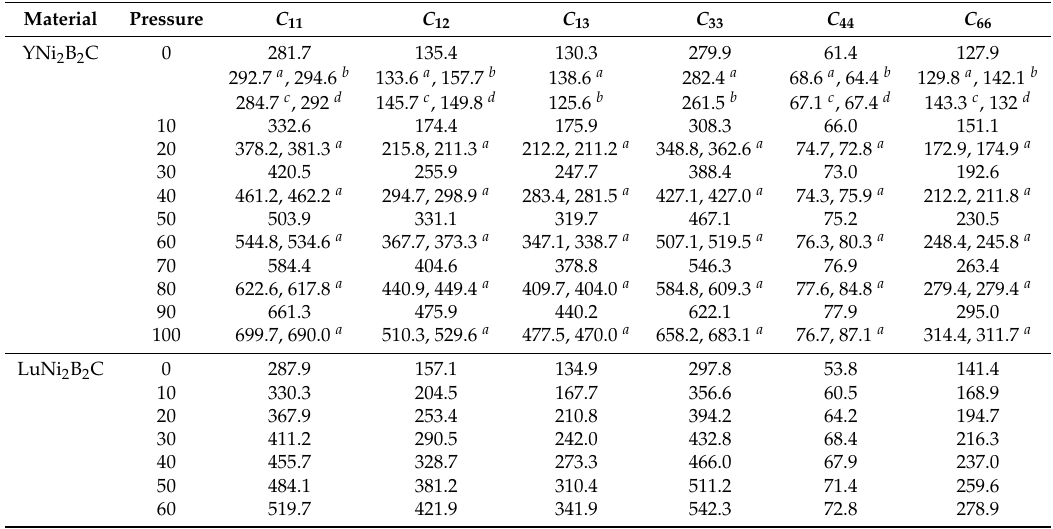
Table 2. Calculated elastic constants C ij (GPa) of RNi 2 B 2 C (R=Y, Lu) under different pressures and compared with available data.